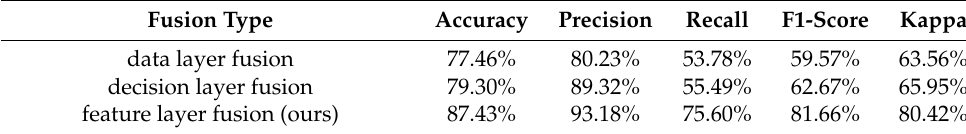
Table 6. Comparison of other fusion methods.